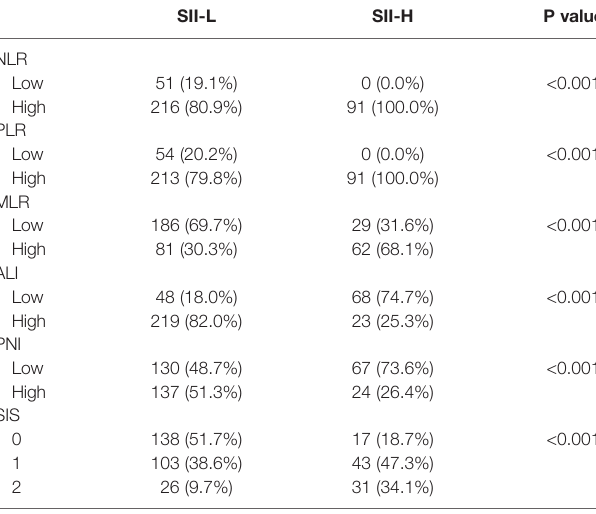
TABLE 2 | Baseline patient clinicopathological characteristics based on systemic immune – in fl ammation index (SII).